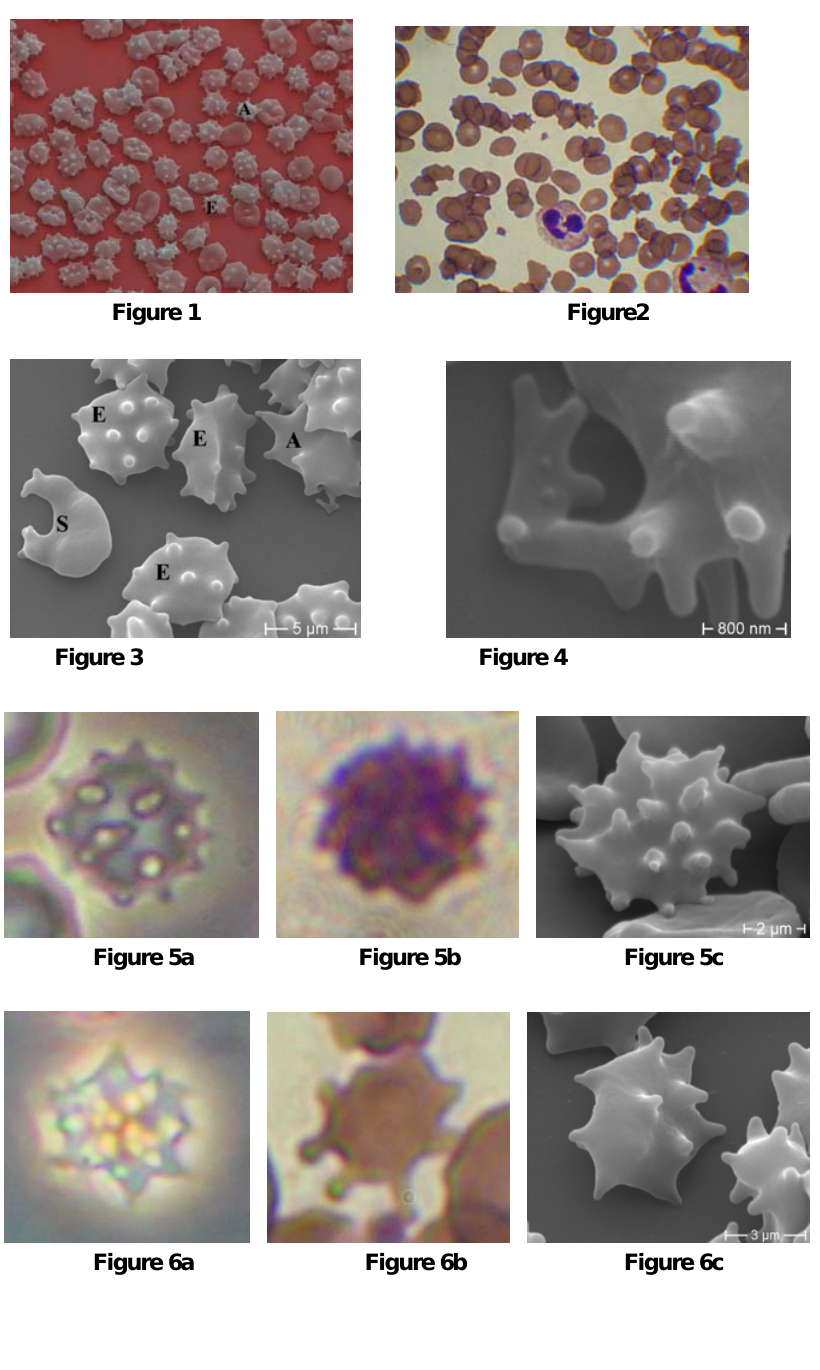
Figure 4 ChAc: Gross deformation of RBC membrane in acanthocyte. Figure 5 Echinocyte in control blood: numerous spiculae regularly distributed in living specimen (DIC 945x) ( 5a ), standard staining (BF 1000x oil) ( 5b ), and Scanning Electron Microscope ( 5c ). Figure 6 Acanthocyte in ChAc: fewer irregularly distributed spiculae, in living specimen (DIC 945x) ( 6a ), standard staining (BF 1000x oil) ( 6b ), and Scanning Electron Microscope ( 6c